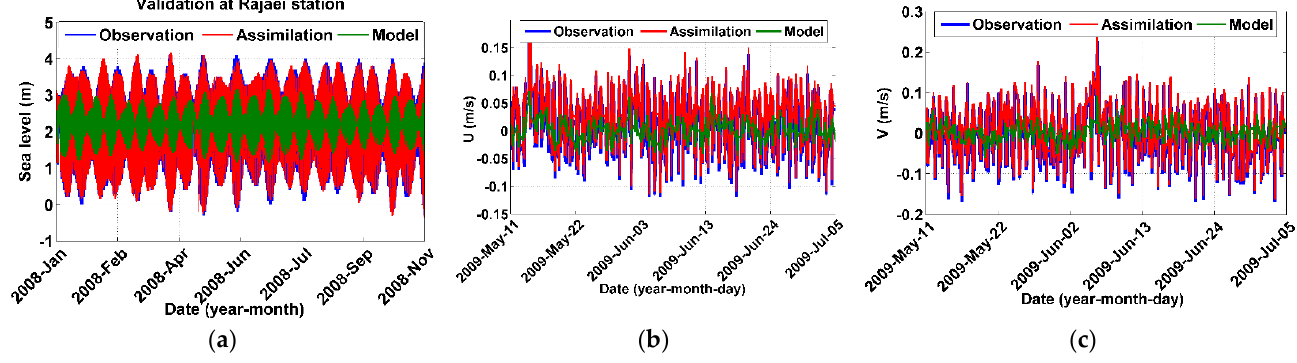
Figure 9. SLH and SSC observations at Rajaei and Nayband control stations obtained from the model before and after data assimilation. ( a ) SLH observations at Rajaei control station (blue), the model before data assimilation (green), and the model after data assimilation (red). ( b ) East–west components of SSC at Nayband control station (blue), the model before data assimilation (green), and the model after data assimilation (red). ( c ) North–south components of SSC at Nayband control station (blue), the model before data assimilation (green), and the model after data assimilation (red).